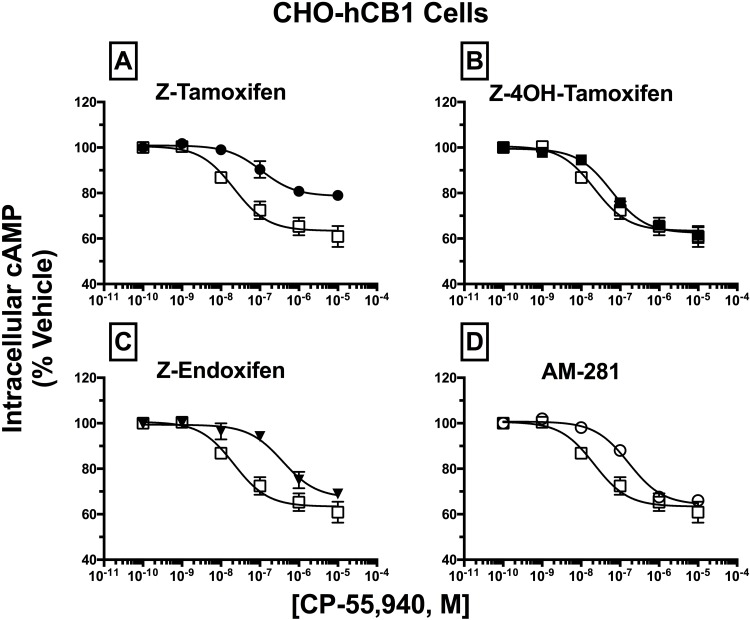
Antagonism of CP-55,940 inhibition of forskolin-stimulated AC activity by SERM isomers in intact CHO-hCB1 cells.CHO-hCB1 cells were pre-incubated for 30 min with receptor saturating concentrations of individual SERMs and were subsequently co-incubated for 7 min with increasing concentrations of CP-55,940. Measurements of CP-55,940 effects alone on potency (IC50) and efficacy (EMAX) of intracellular cAMP were obtained and were compared to the shifts in IC50 and EMAX values observed in [A-D]. All IC50, EC50, and KB values (mean ± SEM) were derived from non-linear regression analysis of the curves shown in [A-D] and are presented in Table 3 with statistical analysis. Open squares represent the concentration-effect curve for CP-55,940 alone, while filled symbols represent the action of CP-55,940 in the presence of the SERM indicated [A-C] or the selective CB1R inverse agonist AM-281 [D].